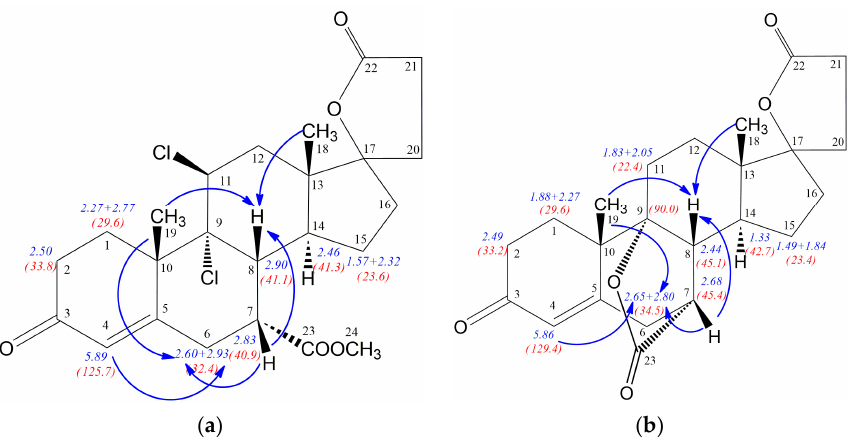
Figure 6. Crucial 1 H- and 13 C-NMR chemical shifts and NOE effects for: ( a ) (7 α ,11 β ,17 α )-9,11-dichloro derivative 13 ; ( b ) 7 α ,9:21,17-dicarbolactone 14 .